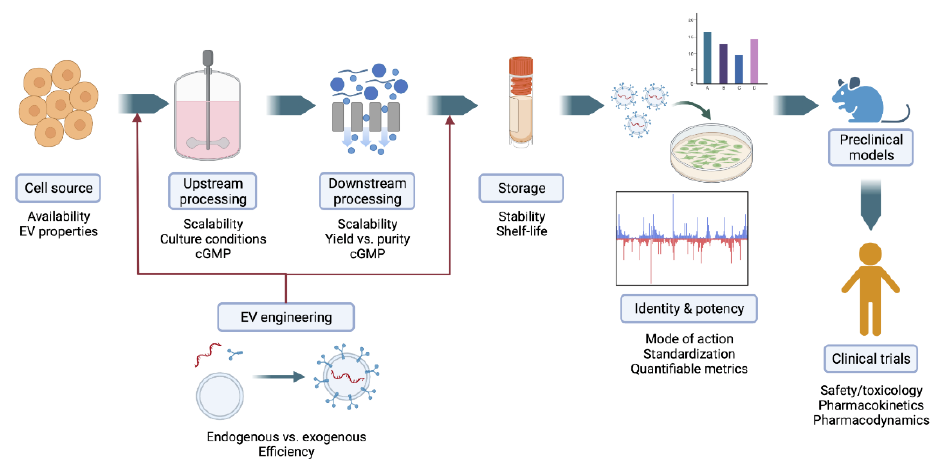
Figure 3. Key factors for the translation of extracellular vesicle (EV)-based therapeutics into clinical settings. Figure created with BioRender.com.